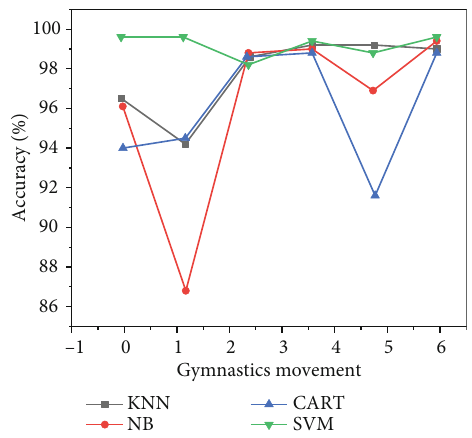
Figure 7: Recognition results of di ff erent classi fi cation